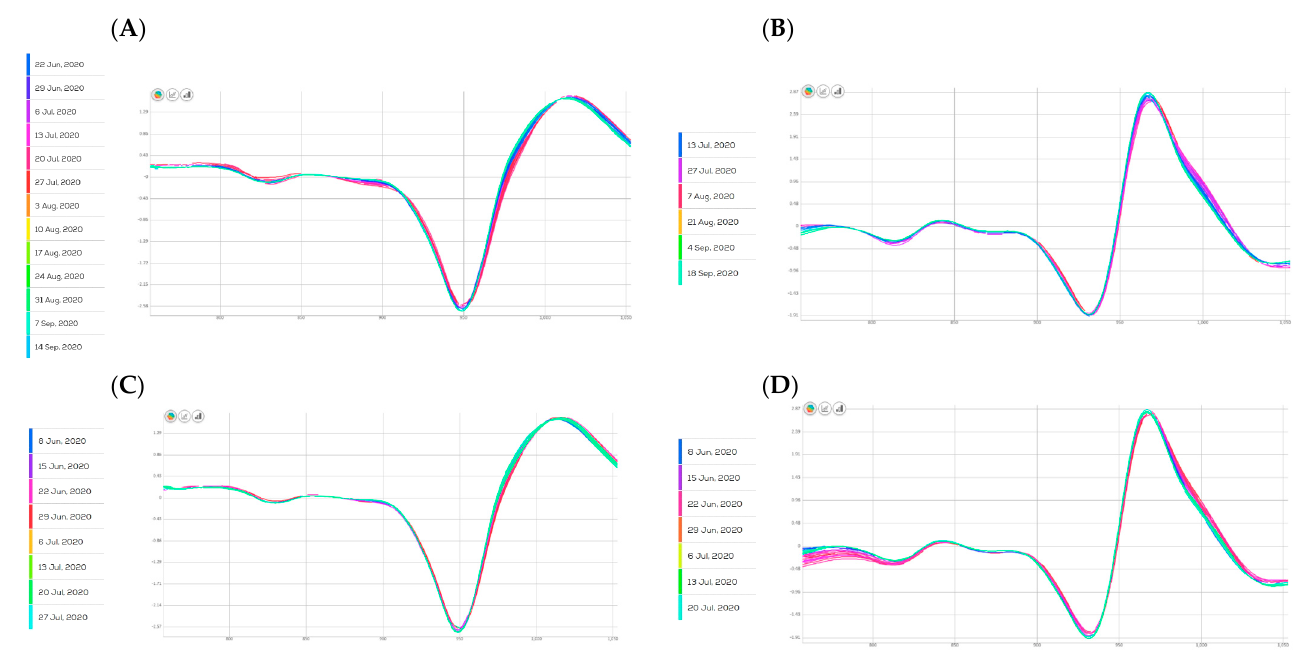
Figure 3. NIR spectra after the pre-treatments for Allison™ ( A ) Autumncrisp ® ( B ) Cotton Candy™ ( C ) and Summer Royal ( D ) in the season 2020. The different colors indicate the various sampling times for each cultivar as shown in the legends.